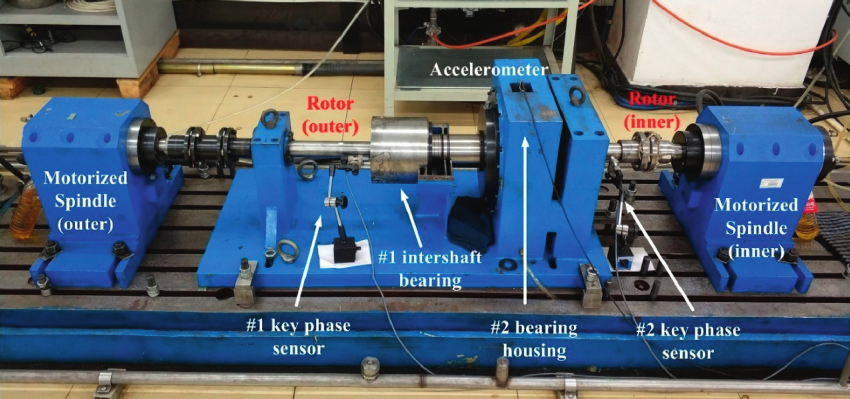
Figure 15: Dual-rotor vibration test